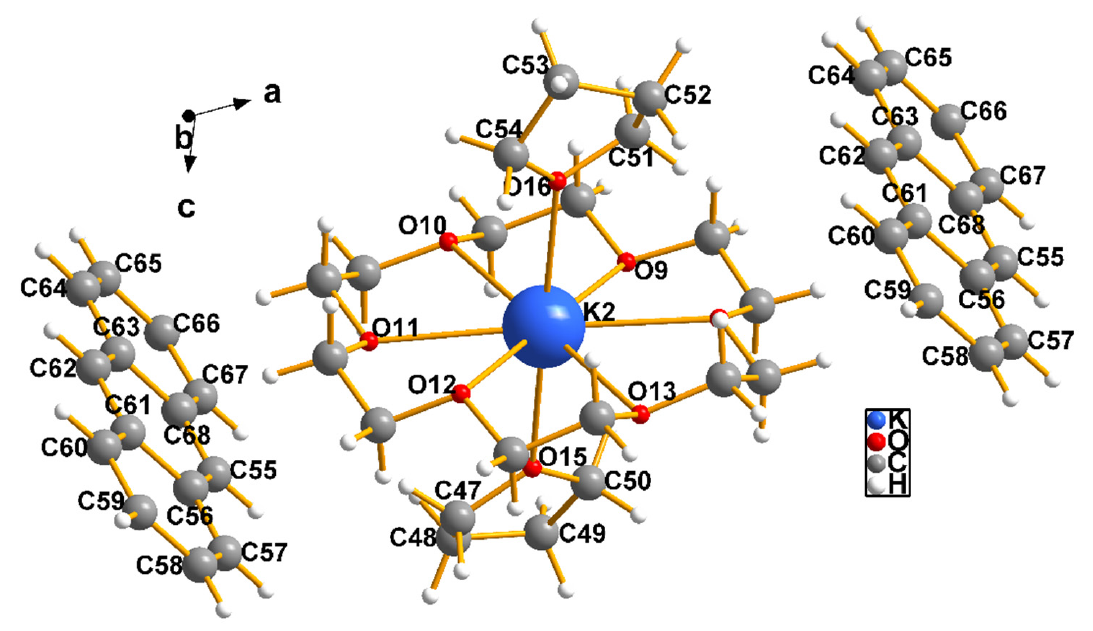
Figure 6. Here, the stereochemistry of both the potassium-crown ether cation and the anthracenide anion can be seen without significant overlap. Figure 7 demonstrates that the anions are literally identical, as shown by an overlay picture generated with Mercury [5] and processed in final form with Diamond [6].